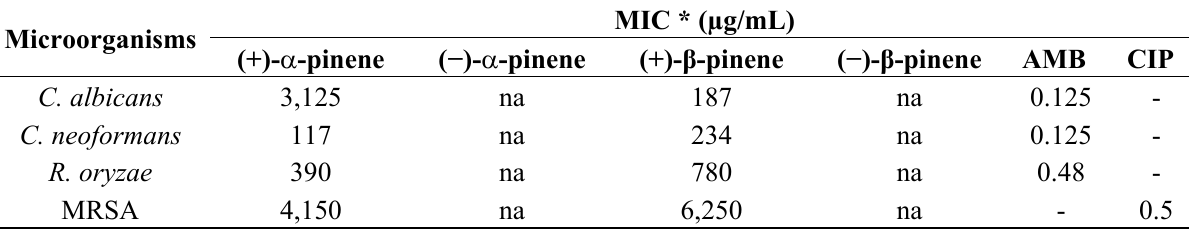
Table 1. Minimal inhibitory concentrations (MICs) of the isomers and enantiomers of pinene and antimicrobial